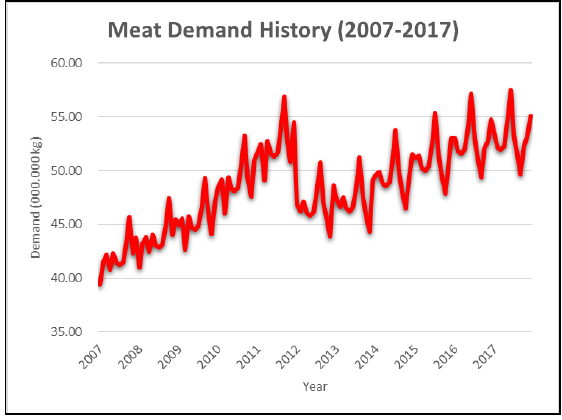
Fig 1. National meat demand in Indonesia for period of 2007 –